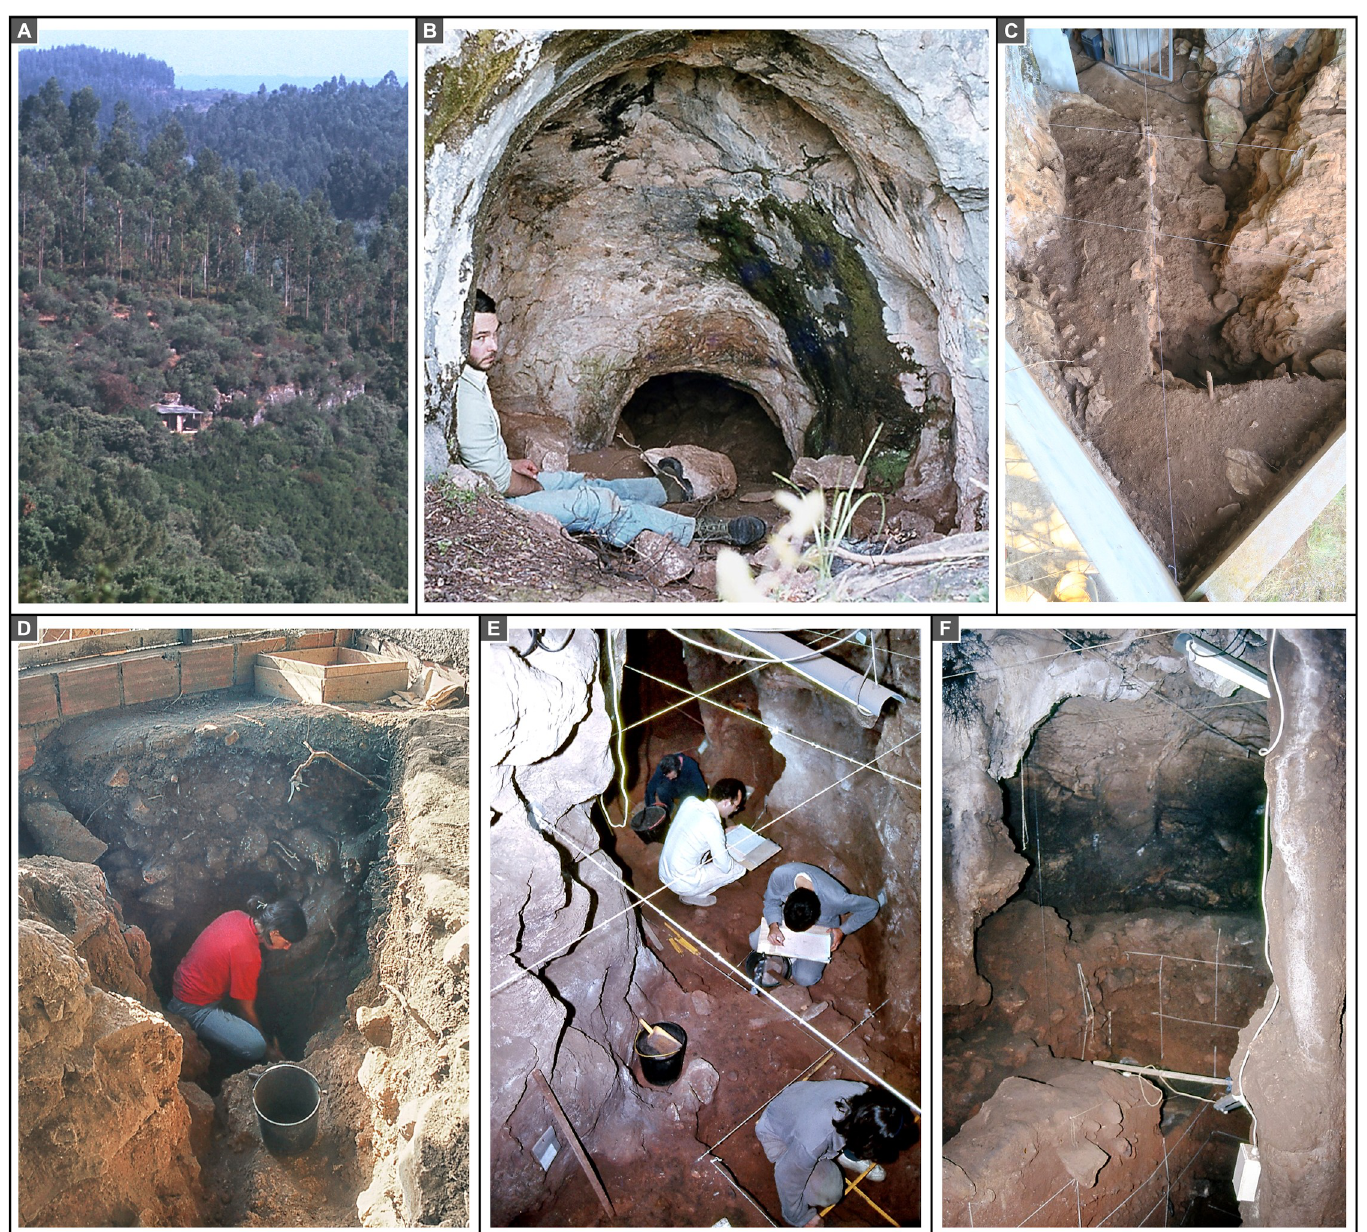
Fig 2. The excavation. A. Overview of the small limestone escarpment where Gruta do Caldeir ã o is located, taken with a zoom lens from the town of Pedreira, 765 m to SSE (1986). B. The cave entrance at the time of discovery (1980). C. The Entrance trench at the end of the 1979–88 fieldwork. D. The Entrance trench during excavation (1987). E. Excavation of the Upper Solutrean deposit in the Corridor area (1985). F. The Back Chamber towards the end of the excavation (1987); the staining of the wall at the bottom end of the chamber denotes the elevation reached by layer ABC-D, the thick black earth deposit of recent Holocene age that originally capped the stratigraphic